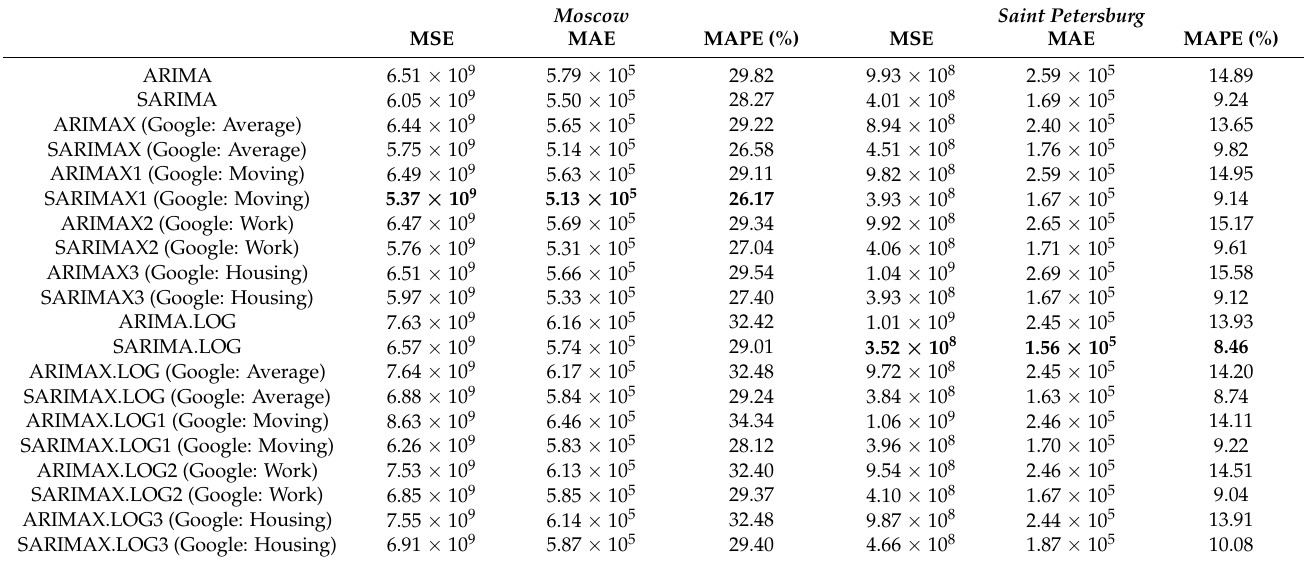
Table 5. Models’ performances according to the mean squared error (MSE), the mean absolute error (MAE), and the mean absolute percentage error (MAPE). The smallest values are reported in bold